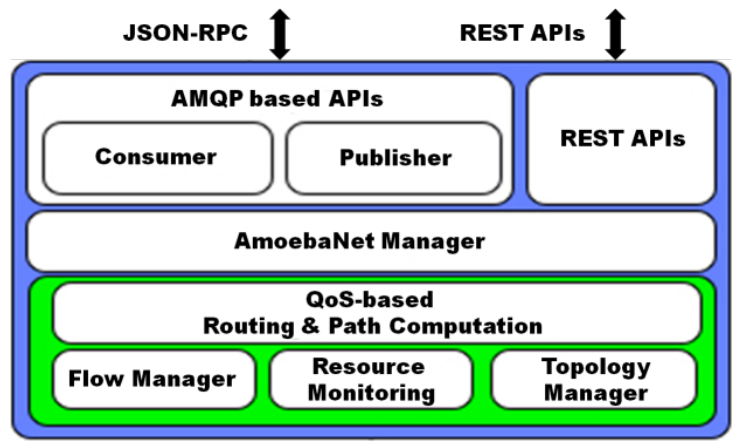
Figure 1. Architecture of the AmoebaNet solution.